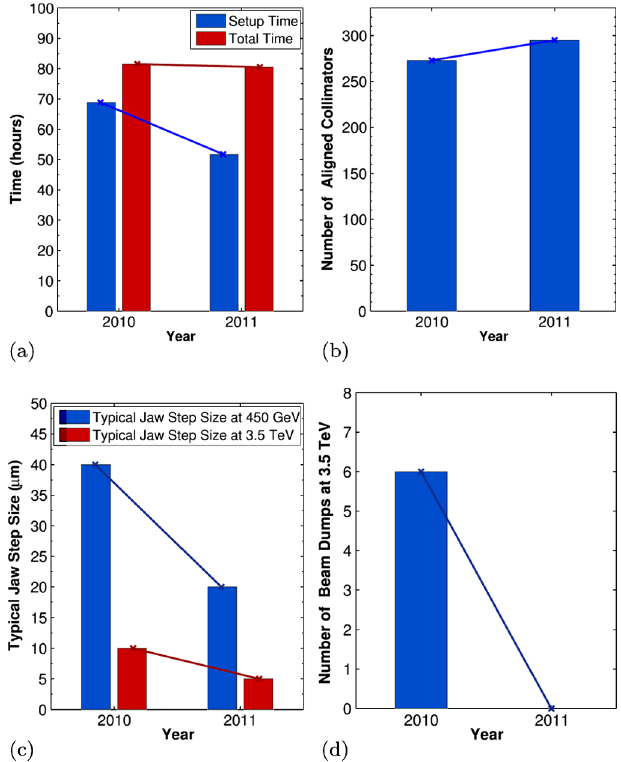
FIG. 11. Summary of the performance gains with semiauto- matic alignment. (a) Setup time. (b) Aligned collimators. (c) Typical jaw step size. (d) Beam dumps at 3.5 TeV.